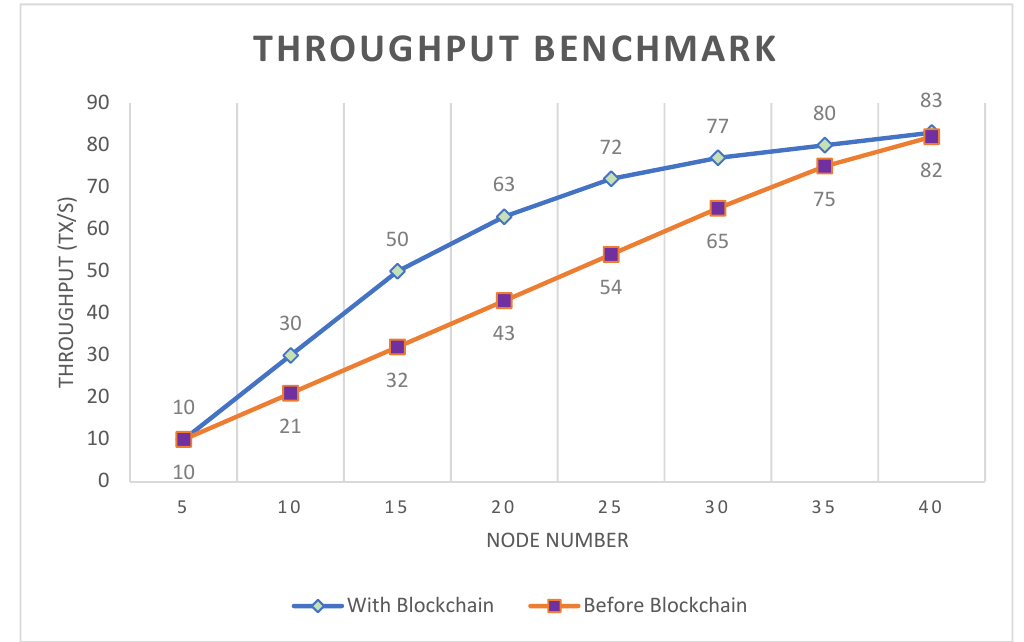
Figure 18. Benchmark of throughput values (with and without blockchain layer).